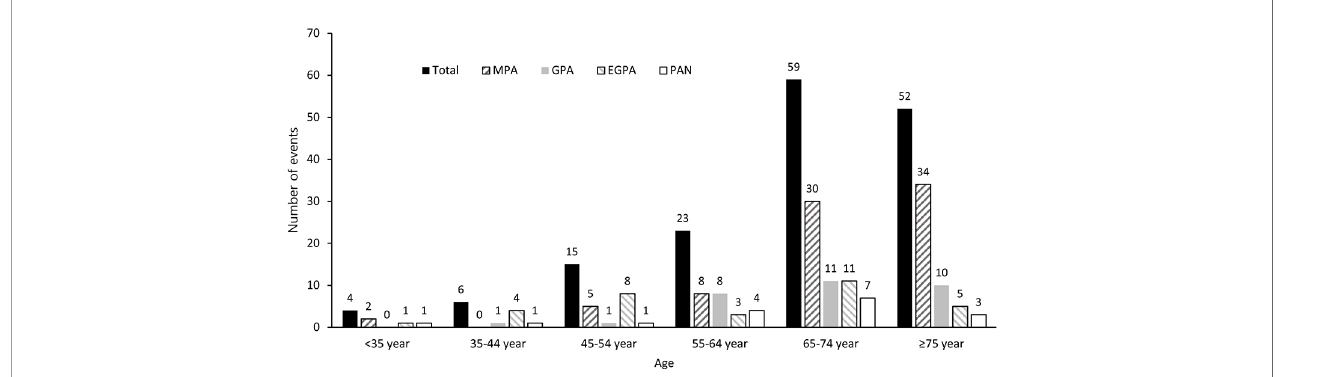
FIGURE 2 | Age distribution of SNV patients on stroke occurrence. The incidence of stroke events was estimated by dividing age into 10-year intervals. SNV, systemic necrotizing vasculitis; MPA, microscopic polyangiitis; GPA, granulomatosis with polyangiitis; EGPA, eosinophilic granulomatosis with polyangiitis; PAN, polyarteritis nodosa.